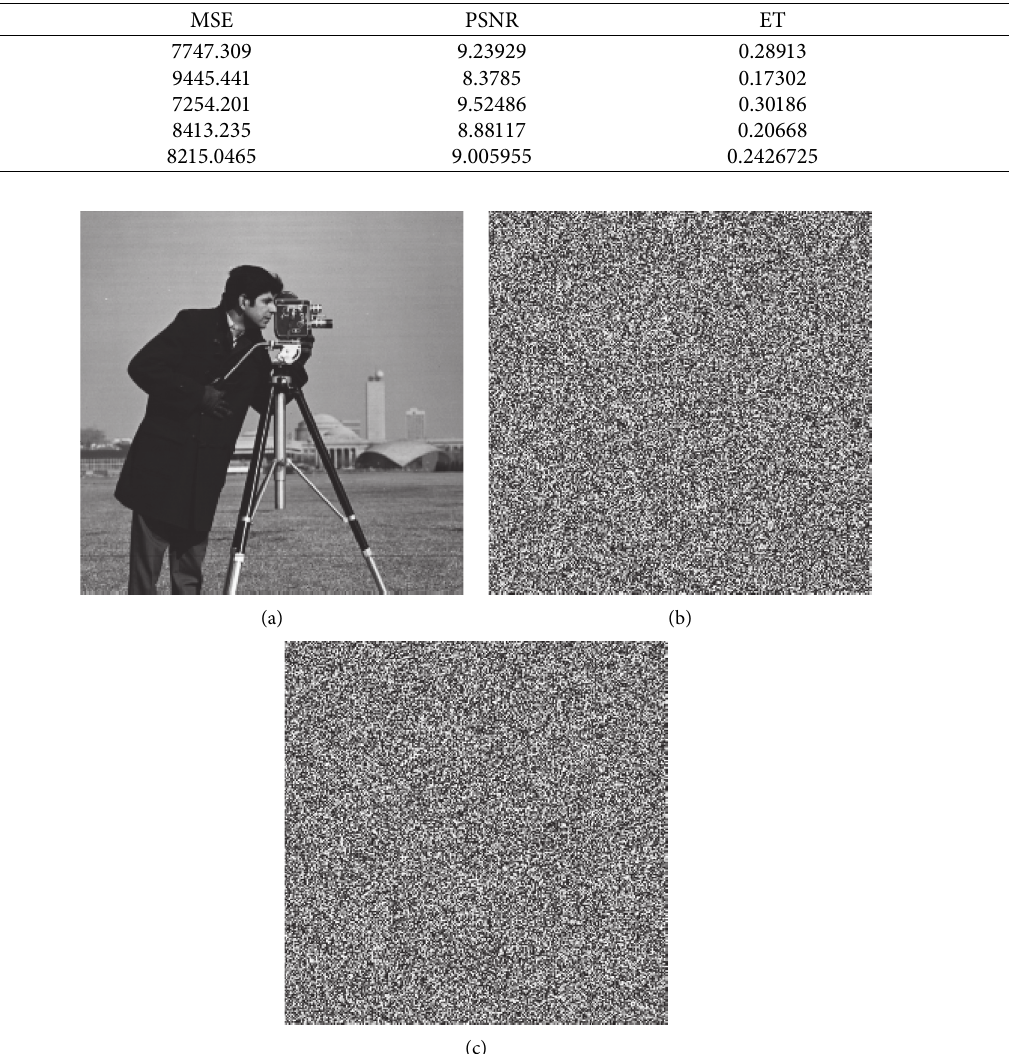
Figure 16: Decrypted process with key sensitivity (a) using same keys of encrypted and (b,c) using the error keys.